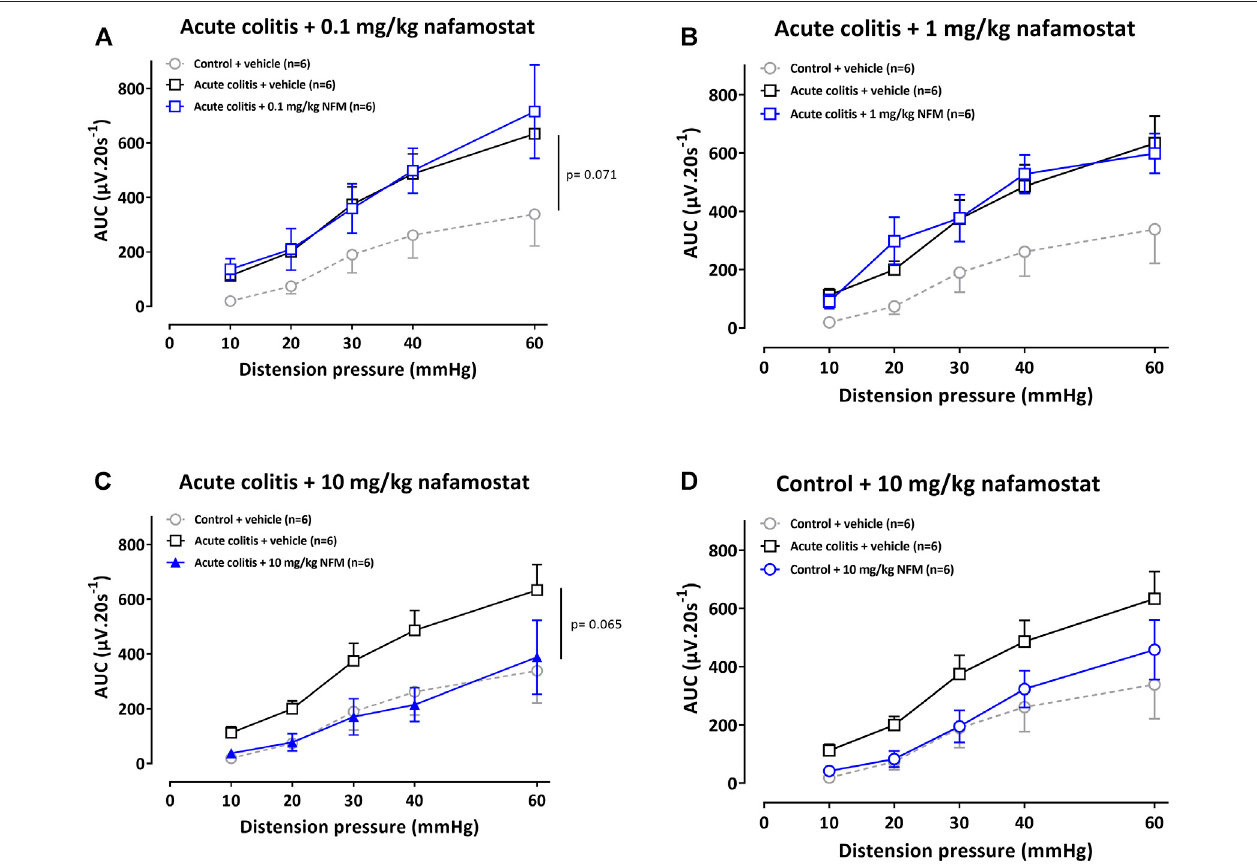
FIGURE 2 | The effect of nafamostat (0.1 – 1 – 10 mg/kg) and vehicle (5% DMSO) on VMRs in acute colitis (A – C) and control (D) rats. The statistical analysis was performed on the complete dataset, but separate graphs were made for the purpose of clari fi cation. Data are presented as mean ± SEM. Generalized Estimating Equations (GEE) + Bonferroni-Holm correction to correct for multiple testing and control for the family-wise error rate across model-speci fi c analyses. n = 6/group; * p < 0.05; signi fi cantly different from control + vehicle. # p < 0.05; signi fi cantly different from acute colitis + vehicle.